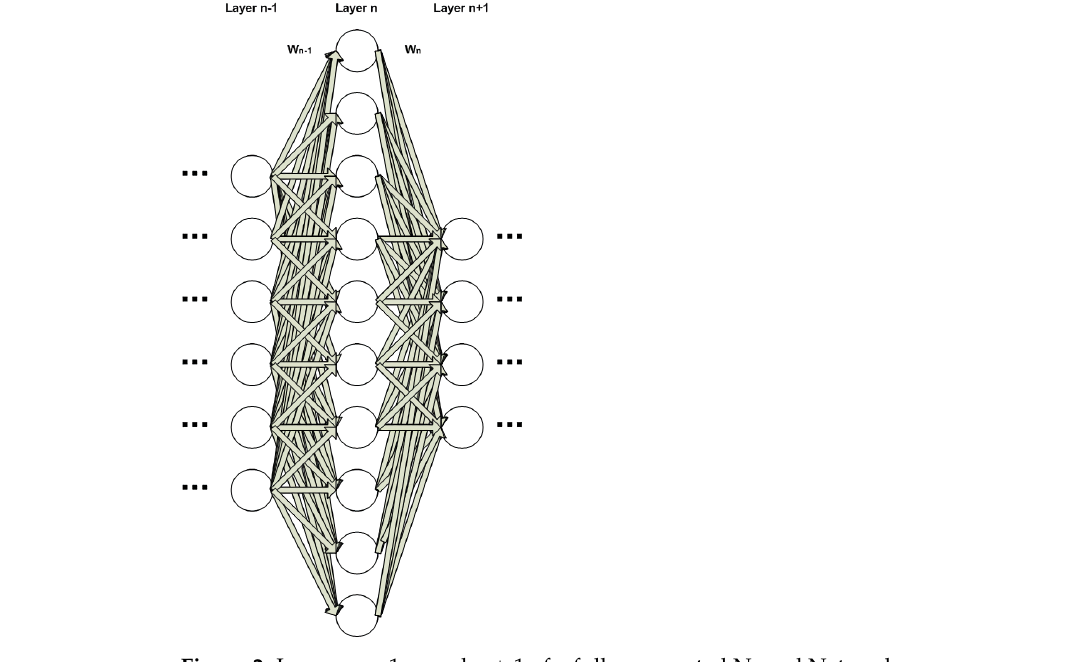
Figure 2. Layers n − 1, n and n + 1 of a fully-connected Neural Network.